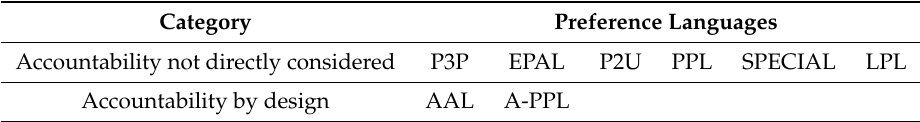
Table 3. Overview of selected privacy languages from the literature, categorised if accountability is considered by design or